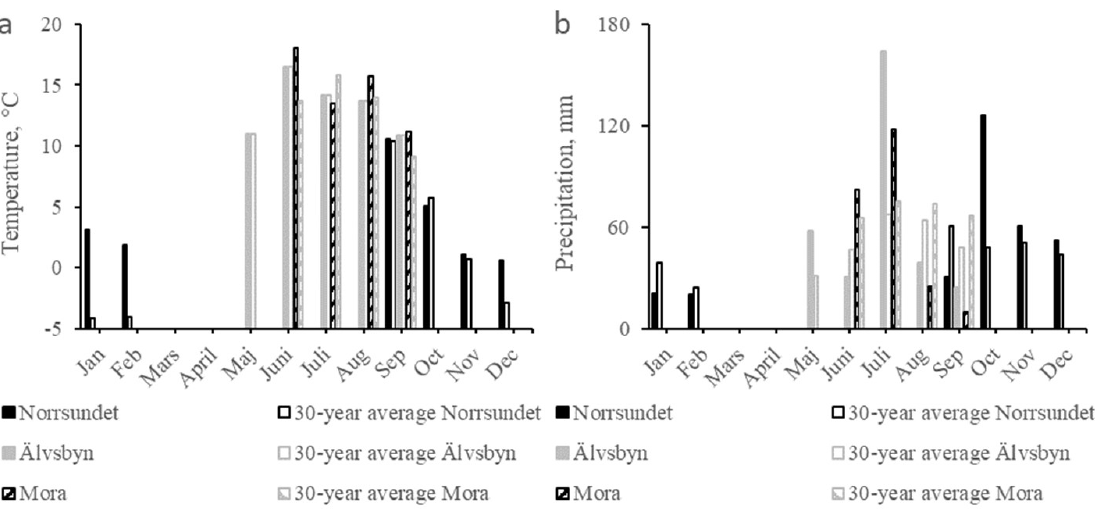
Figure 3. ( a ): Monthly ambient temperature during the storage trials and 30-year average ambient temperature obtained from SMHI, and ( b ): monthly cumulative precipitation during the storage trials and 30-year average precipitation obtained from SMHI.